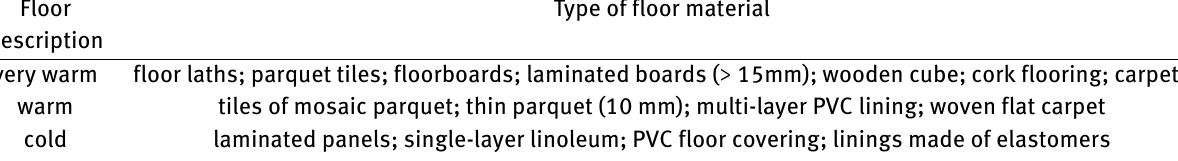
Type of floor material